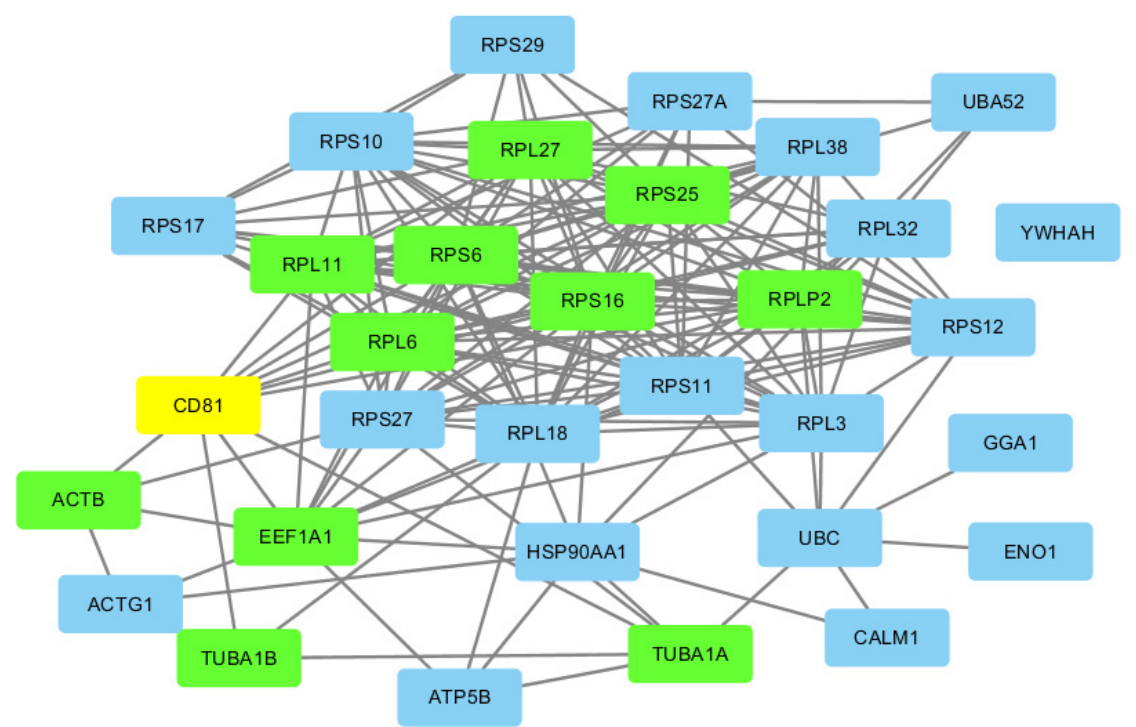
Figure 3. CD81 (yellow) and its nearest neighbors in the PPI network labeled in green.